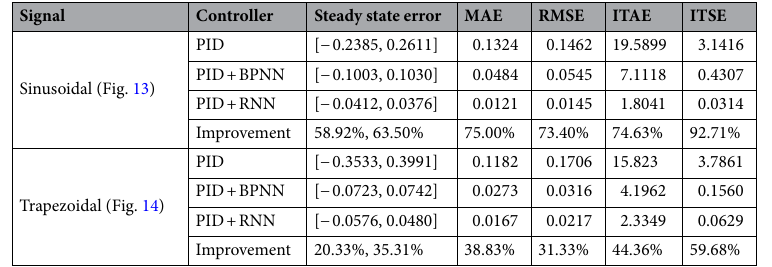
Table 7. Experiment comparisons of tracking sinusoidal and trapezoidal signals.